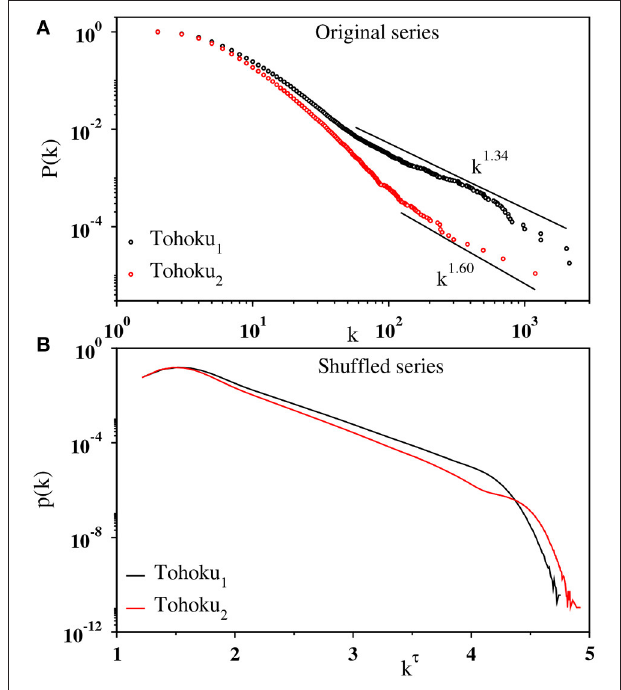
FIGURE 9 | (A) Log-log plot of the cumulative degree distribution P ( k ) for the IET series of Tohoku 1 (black) and Tohoku 2 (red). The slope of the curve in the c x = | | fitted region (solid line) has been estimated as 1.34(5) and 1.60(8), respectively. (B) The degree distribution p ( k ) shown as a function of k τ with k being the degree of the nodes for shuffled sequences of the corresponding data on a semi-log scale. Here the exponent τ is estimated as 0.30 and 0.28,